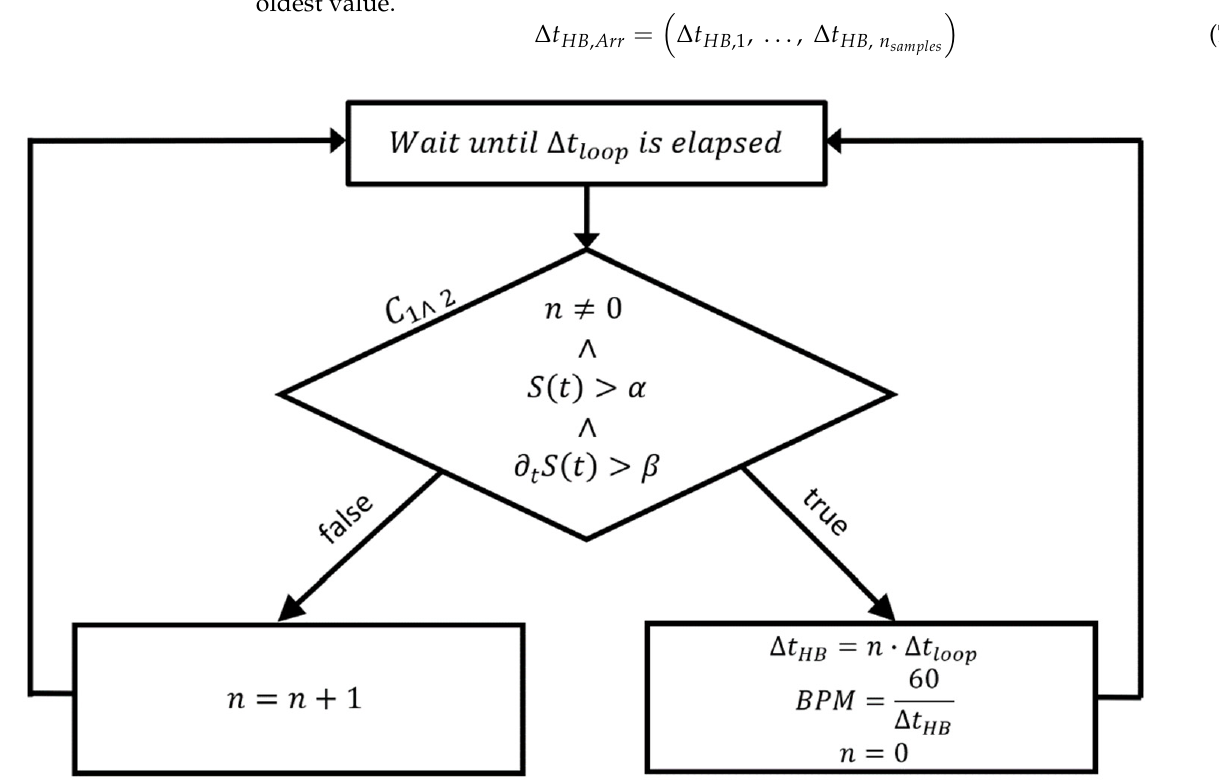
Figure 7. Flowchart of beats per minute (BPM) calculation. The other parameters are described in the main text.